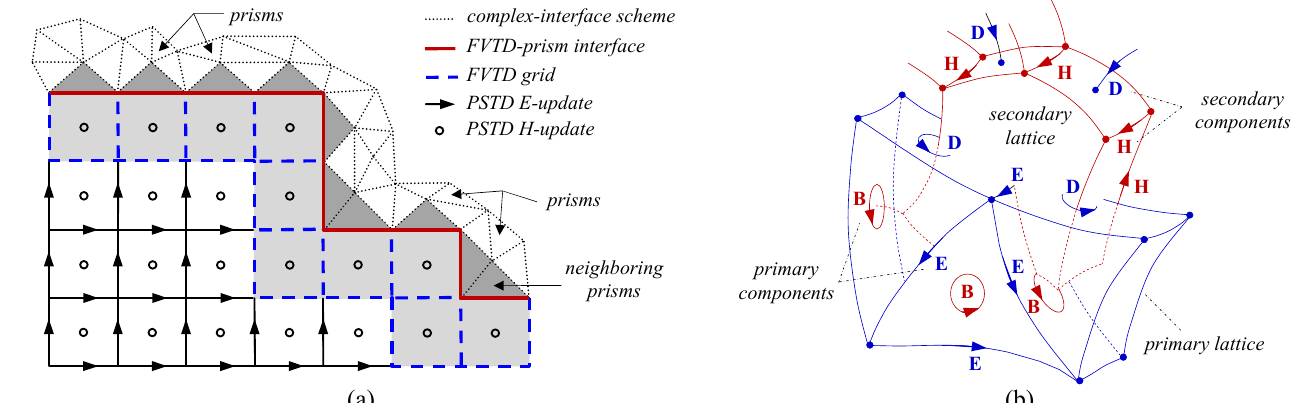
Figure 3: (a) A transverse cut of the hybrid interface for an orthogonal discretization between the complex-interface (prism re- gion), the FVTD (light grey region), and the PSTD (white region) lattices. Dotted (black) lines notify evaluations via the complex- interface scheme, dashed (blue) lines indicate computations through the FVTD method, and straight (black) lines represent calcu- lations via the PSTD technique. (b) A non-orthogonal dual-grid cell complex with the primary (blue) and secondary (red)